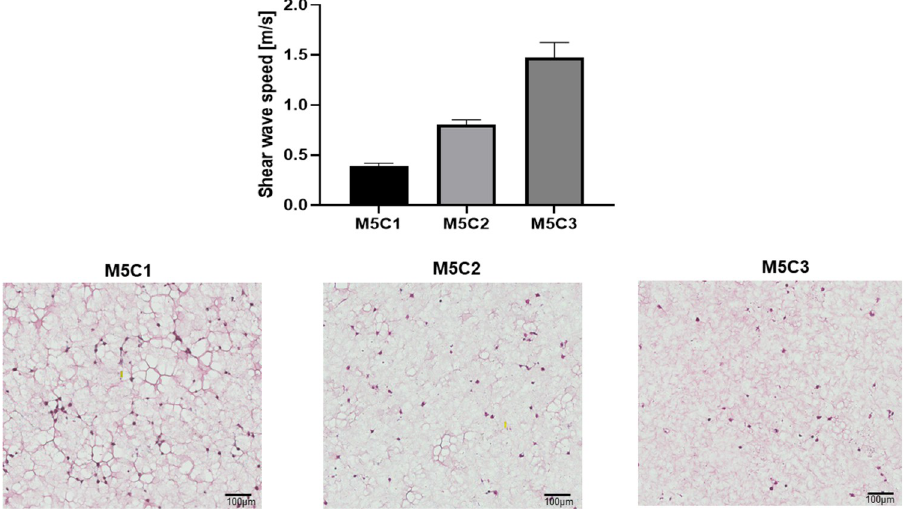
Fig 5. SWSs measured for cell-laden gels with 5 mg/ml Matrigel and 1 mg/ml (M5C1), 2 mg/ml (M5C2), and 3 mg/ml (M5C3) collagen type I. Data are mean and standard-error values for three independent experiments. The lower panels are H&E-stained images of the respective regions of the cell culture samples. The pore size in the matrix decreased as the collagen concentration